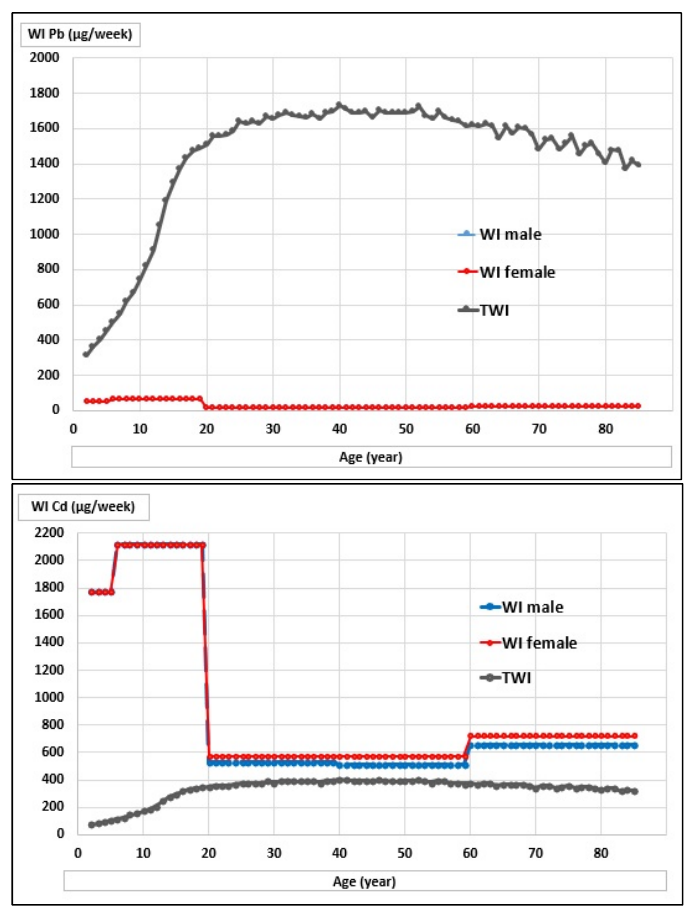
Figure 2. Weekly intake of Pb and Cd by age and sex in relation to the provisional maximum weekly intake (µg). At the top is the Pb WI, and at the bottom is the Cd WI.